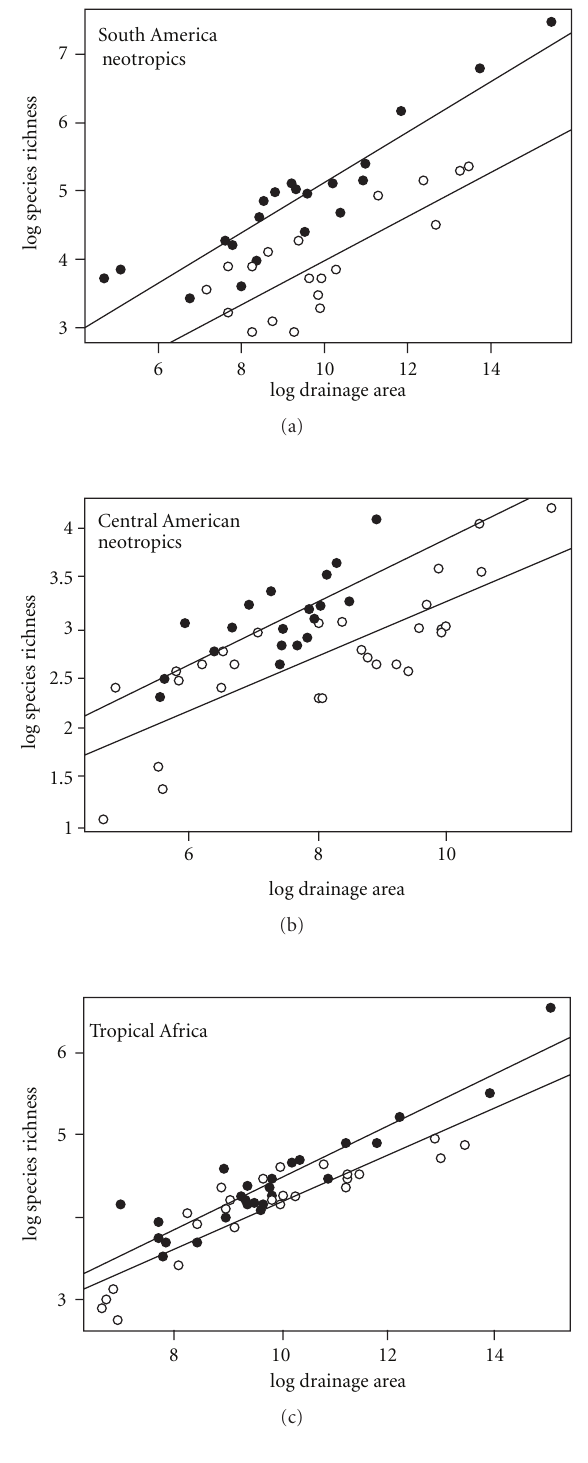
Figure 5: Plot of species richness as a function of total surface area of the drainage for river basins from tropical South America, Central America and tropical Africa. Black circles represent the basins that were in contact with a rain forest refuge zone during the LGM; white circles represent basins completely isolated from rain forest refuges. Lines correspond to simple linear regressions for each group. Variables are expressed in logarithmic values (Ln): redrawn from Tedesco et al.